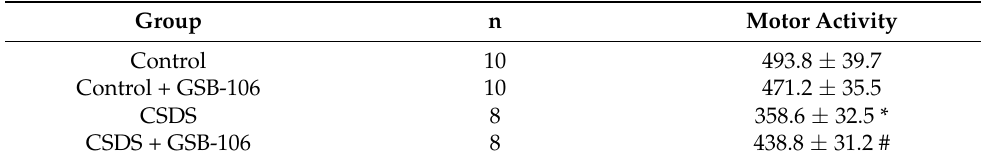
Table 2. Effect of dipeptide GSB-106 on locomotion in CSDS